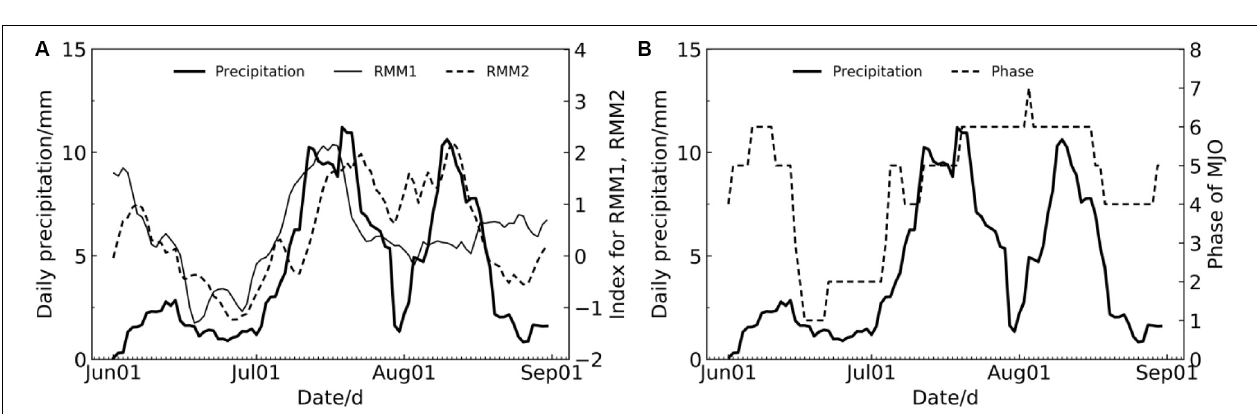
FIGURE 2 | Power spectrum and distribution of the Morlet wavelet coefficient for precipitation in North China in the summer of 2018. Shaded areas exceed the 95% confidence level. (A) The power spectrum, the dotted line is the power spectrum of white noise with 95% confidence level, and the solid line is the power spectrum of precipitation. (B) The Morlet wavelet coefficient map of daily precipitation, the positive and negative isolines are the distribution of coefficient, the numerical values represent the fluctuation of precipitation, and the shaded areas passed the 95% confidence level.